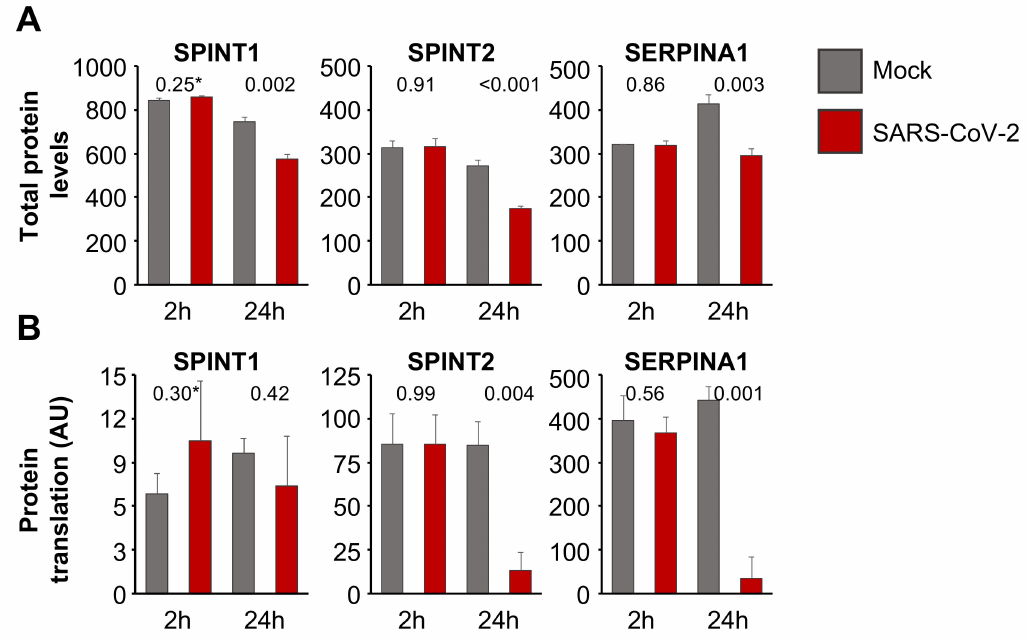
Figure 4. Regulation of host cell protease inhibitors in SARS-CoV-2-infected cells. ( A ) Total protein levels based on a publicly available proteomics dataset [35], indicating cellular levels of endogenous protease inhibitors in SARS-CoV-2 (MOI of 1)-infected Caco2 cells 2 h and 24 h post-infection. Data were normalized using summed intensity normalization for sample loading, followed by internal reference scaling and trimmed mean of M normalization. * p -values as determined using a two-sided Student’s t -test. ( B )Meanproteintranslationofendogenousproteaseinhibitorsinarbitraryunits(AU)(normalized and corrected summed peptide spectrum matches (PSMs) were averaged) in SARS-CoV-2 (MOI of 1)-infected Caco2 cells 2 h and 24 h post-infection based on a publicly available translatome dataset [35]. * p -values as determined using a two-sided Student’s t